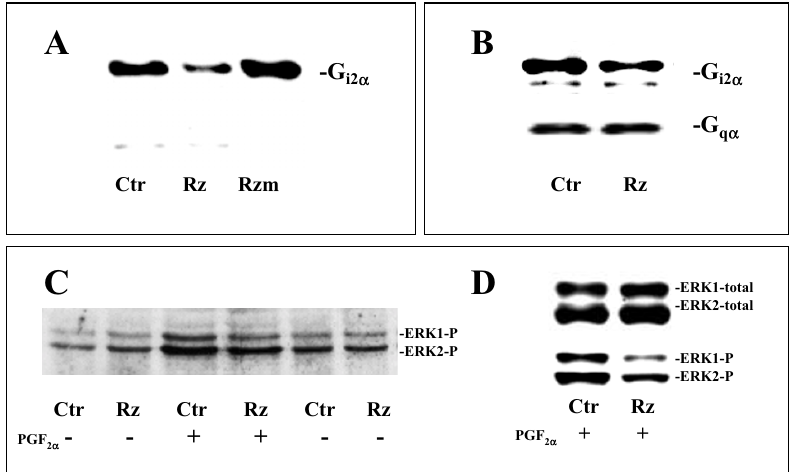
Figure 3 Western analysis of the effects of ribozyme on G i2 α and ERK1/2. G i2 α ribozyme (Rz) or non-cleaving G i2 α ribozyme (Rzm) complexed with DOTAP giving final ribozyme concentrations of 2.5 µ M, or only DOTAP (Ctr) were added to hepato- cyte cultures at 4–5 hours after the time of seeding. A: Expression of G i2 α protein was assessed after 45 h of ribozyme treat- ment using antibody (from Calbiochem) directed against C-terminal end of G i1/i2 α . B: Expression of G i2 α and G q α protein levels in the same samples subsequent to 30 h of ribozyme treatment using antibodies (from NEN™ Life Science Products) against C-terminal sequences of G i1/i2 α or G q α , respectively. The polyclonal antibodies used to assess G i2 α recognize both the α subunit of G i2 and G i1 . As shown previously hepatocytes do not express G i1 α [19], so the reactivity with these antibodies reflects only the G i2 α levels. C, D: After 45 h of ribozyme treatment cells were stimulated with or without PGF 2 α (10 µ M)